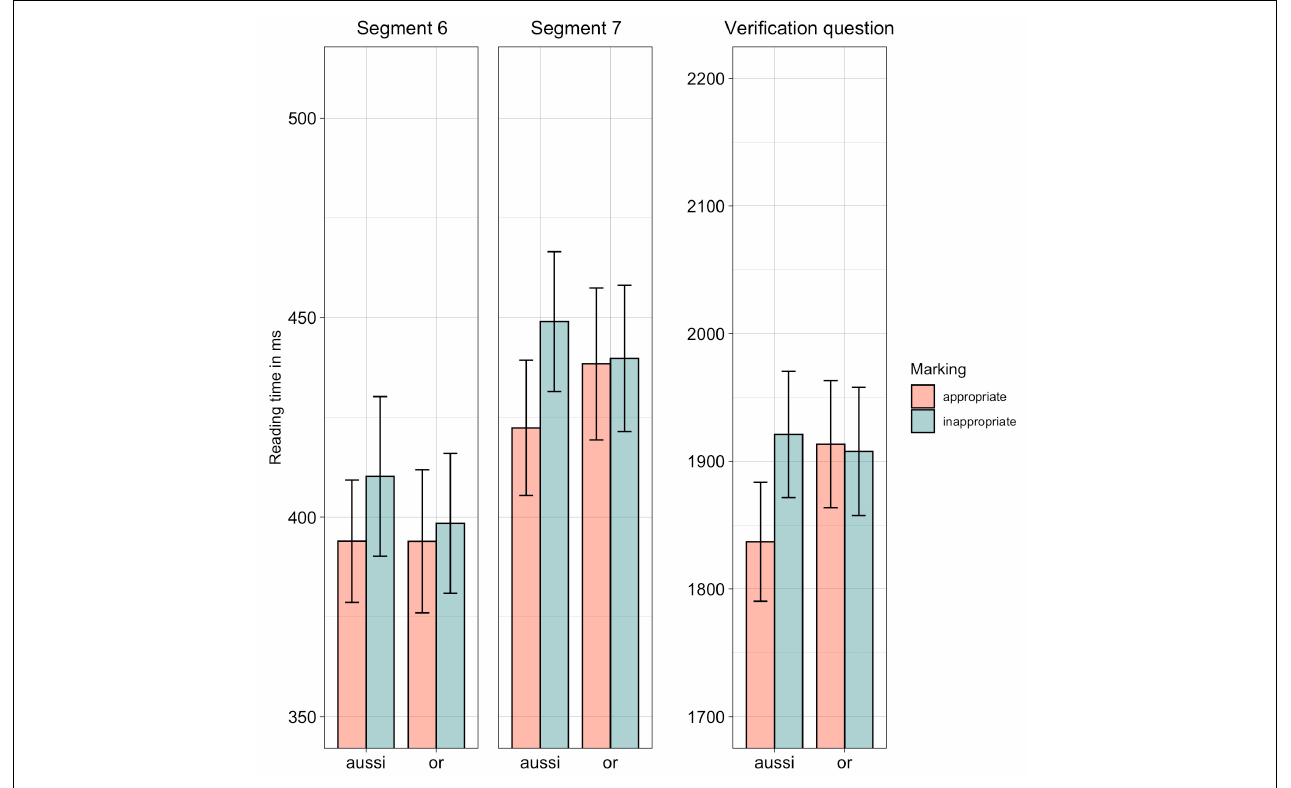
FIGURE 3 | Experiment 3, reading times for Segments 6 and 7 as well as response times to the verification question. CI of 95% as error bars.